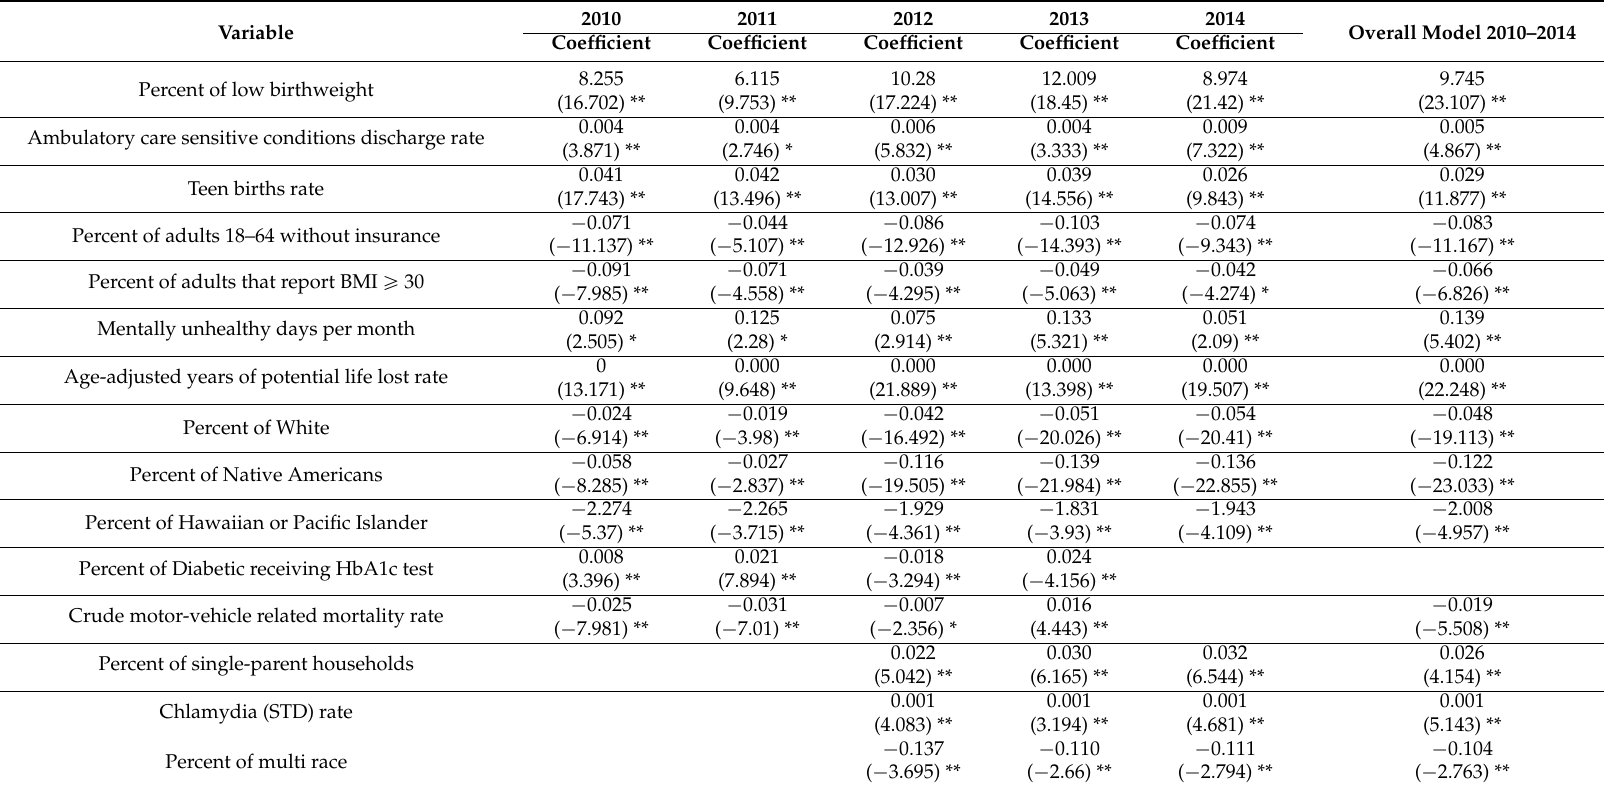
Table 2. Estimates of multivariate linear regression model for low birthweight. Nine influential predictors were consistently present in all of the six models and were able to explain low birthweight outcomes in 2010, 2011, 2012, 2013, and